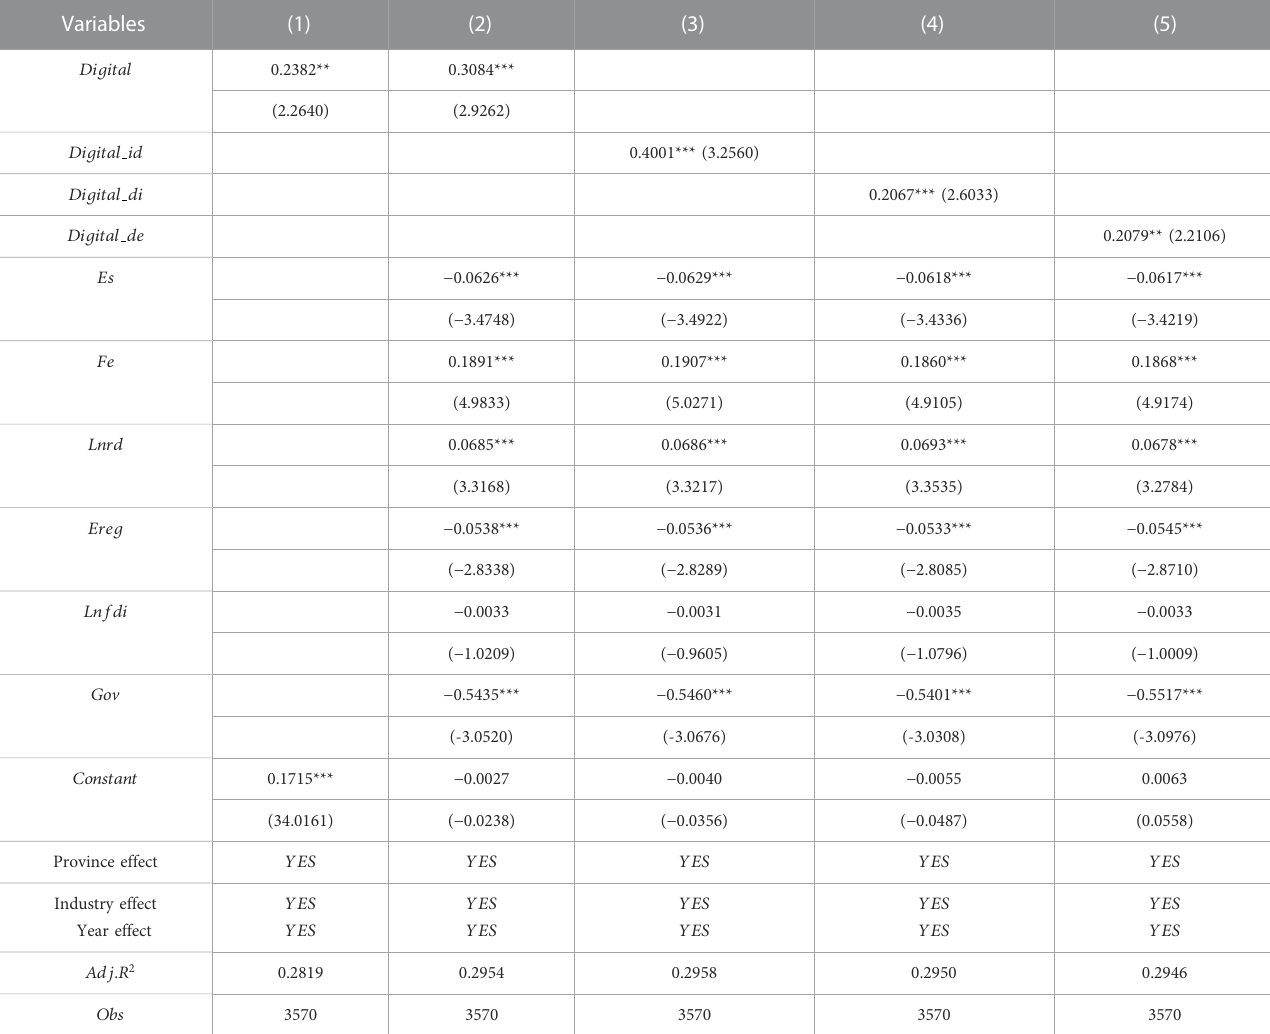
TABLE 5 Results of benchmark regression and further analysis a